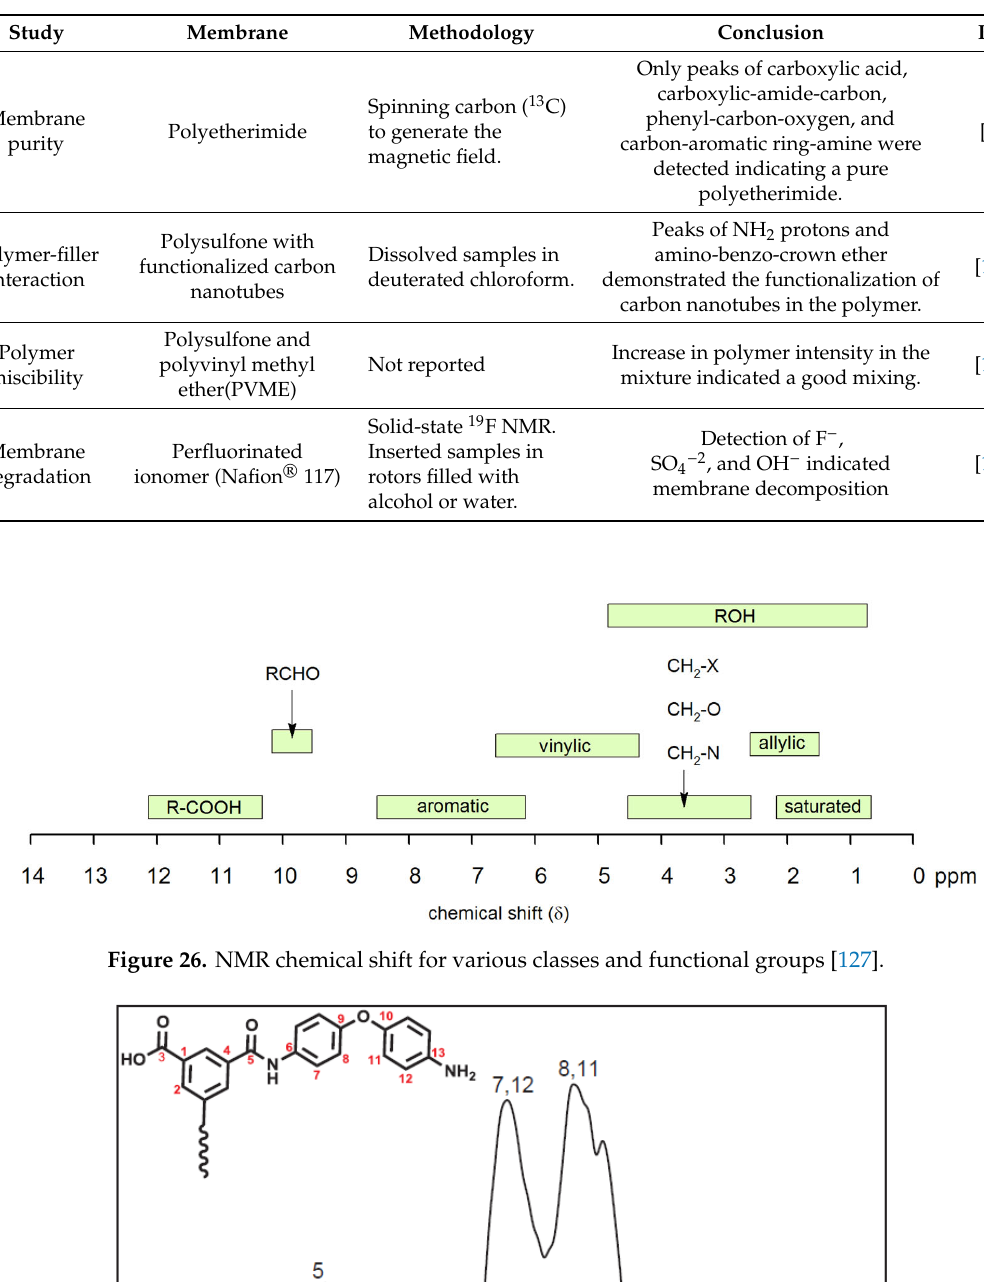
Table 9. Characterization of polymeric membranes by NMR.